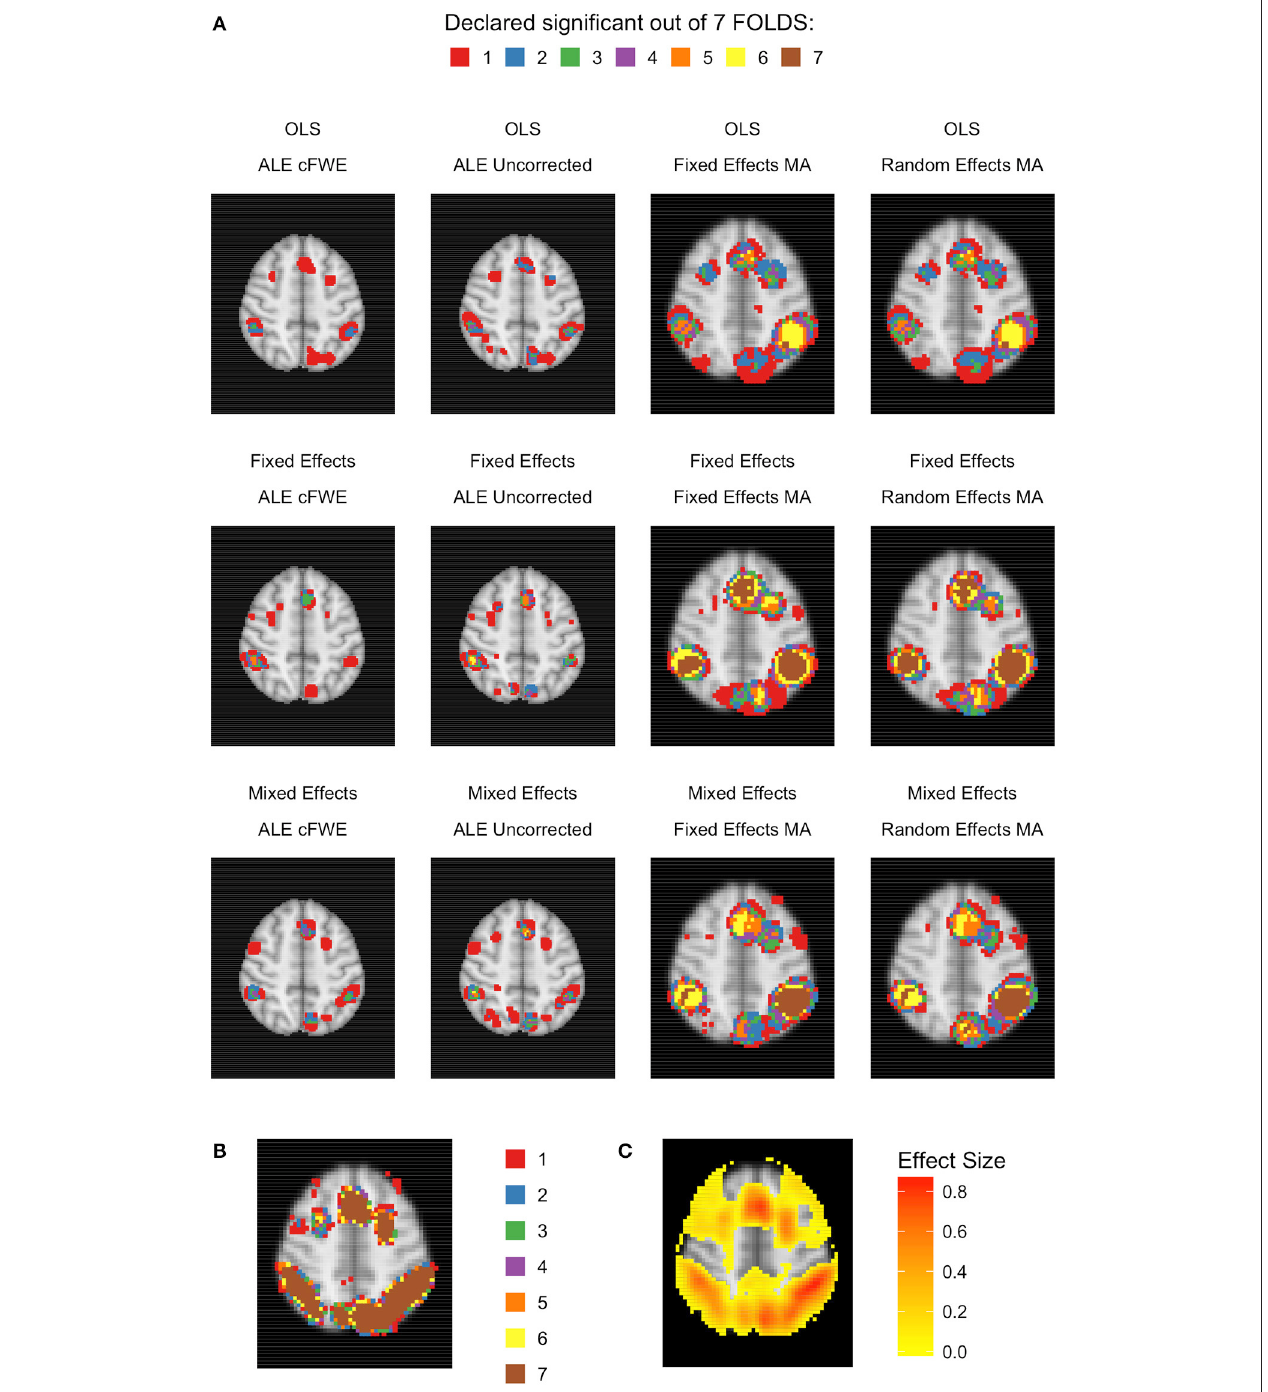
FIGURE 11 | Heatmaps of MNI z-coordinate 50 for K 10. (A) The number of folds in which each voxel has been declared statistically significant for each = combination of a group level model (row-wise) and thresholded meta-analysis (column-wise). Note that the resolution of the images corresponding to the analyses within either ALE or the fixed and random effects CBMA is different (see main text). (B) The number of folds in which each voxel of the reference images has been declared statistically significant. Areas of interest involve the supramarginal gyrus (posterior division), superior parietal lobule and angular gyrus. (C) Average effect size of the reference images over the